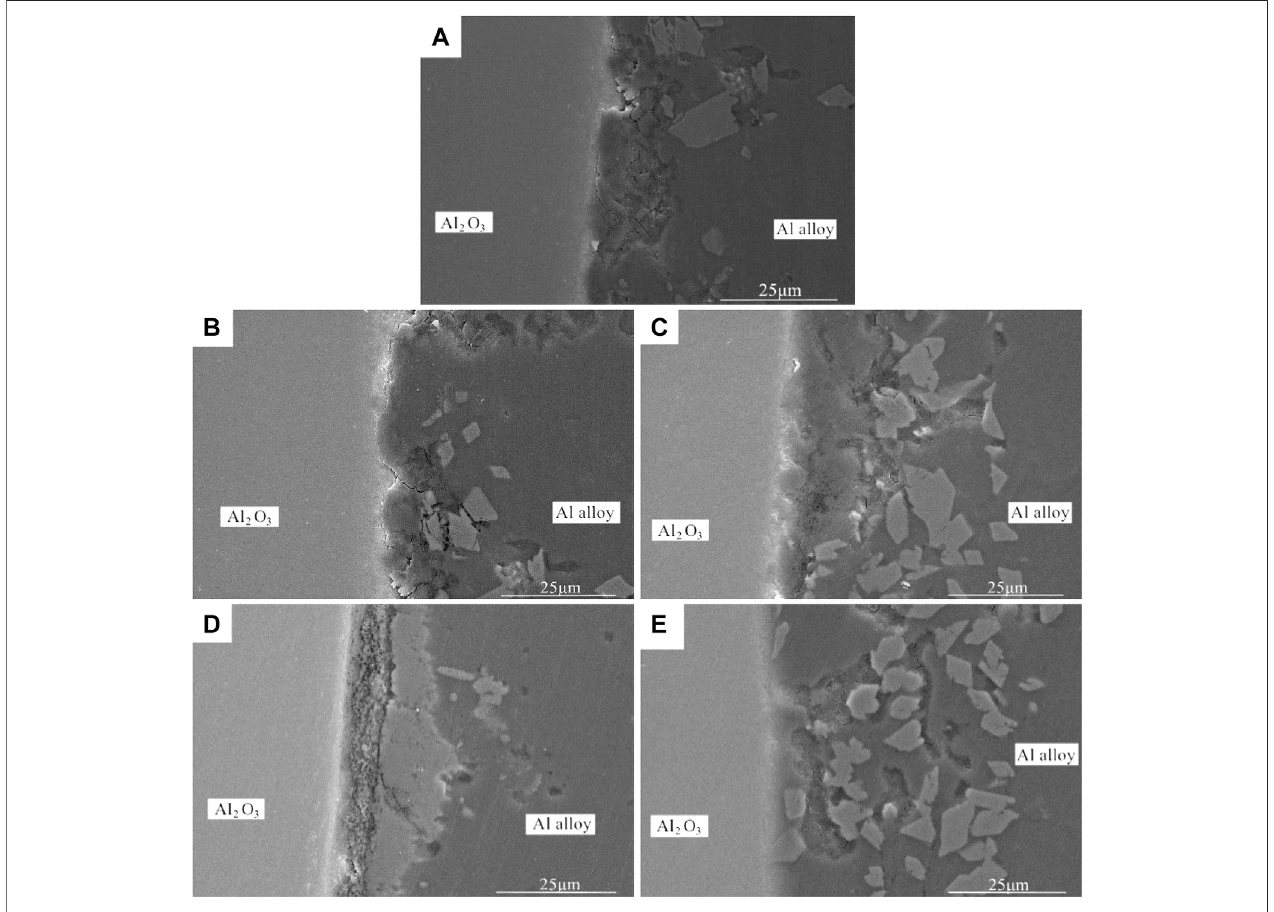
FIGURE4| MicromorphologyoftheAl 2 O 3 (Ni)ceramic-aluminumalloyjointsafter1 hheattreatmentatdifferenttemperatures: (A) 200 ° C, (B) 250 ° C, (C) 300 ° C, (D) 350 ° C, (E) 400 ° C.